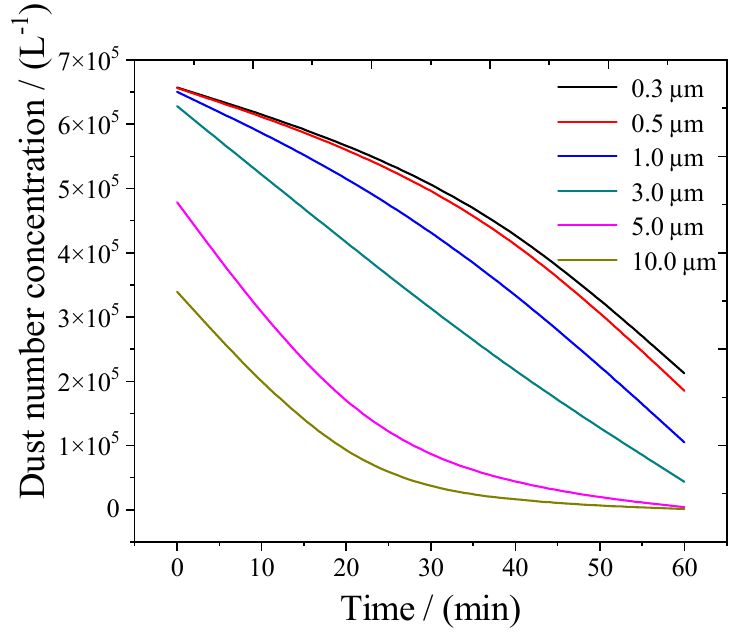
Figure 6. Dust particle concentration during the deposition Figure 5. Dust particle concentration during the deposition process.